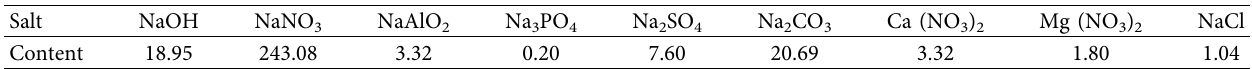
Table 2: The salts composition of LILRW (g/L). (Table 2 is reproduced from [23]). Salt NaOH NaNO 3